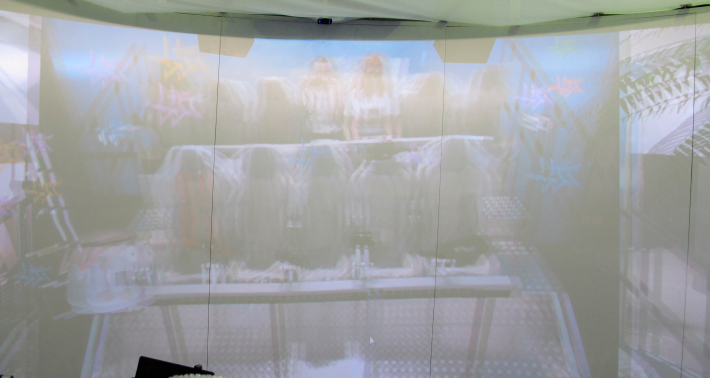
Figure 8. Audience immersed in the augmented reality mirror-based scenario (in the laboratory environment). One person receives the visit of the virtual character that congratulates him for being the winner (note that the provided image is taken from the real scenario, and so the two stereoscopic images are depicted).